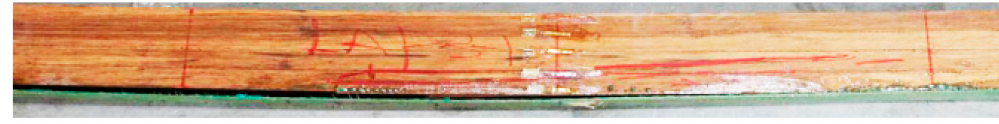
Figure 7. Failure photos for